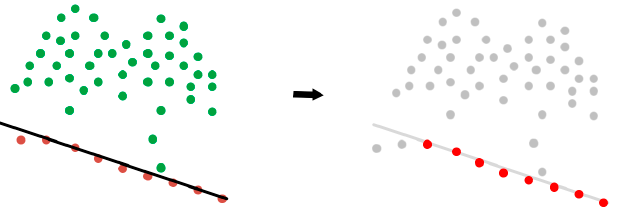
Figure 2. Ground seed enhancement with line segmentation. Ground seeds identified only using the method ( a ) without and ( b ) with line segmentation. Ground seeds can be supplemented on raised terrain, where it is difficult for ground seeds to be identified by selecting the lowest points within the windows. Black lines and red pentagrams represent line primitives and ground seeds, respectively. Figure 3. Ground seed identification on raised terrain by using the RANSAC line segmentation method. Brown points, green points, red points and black lines represent ground points, vegetation points, ground seeds and line primitives, respectively.